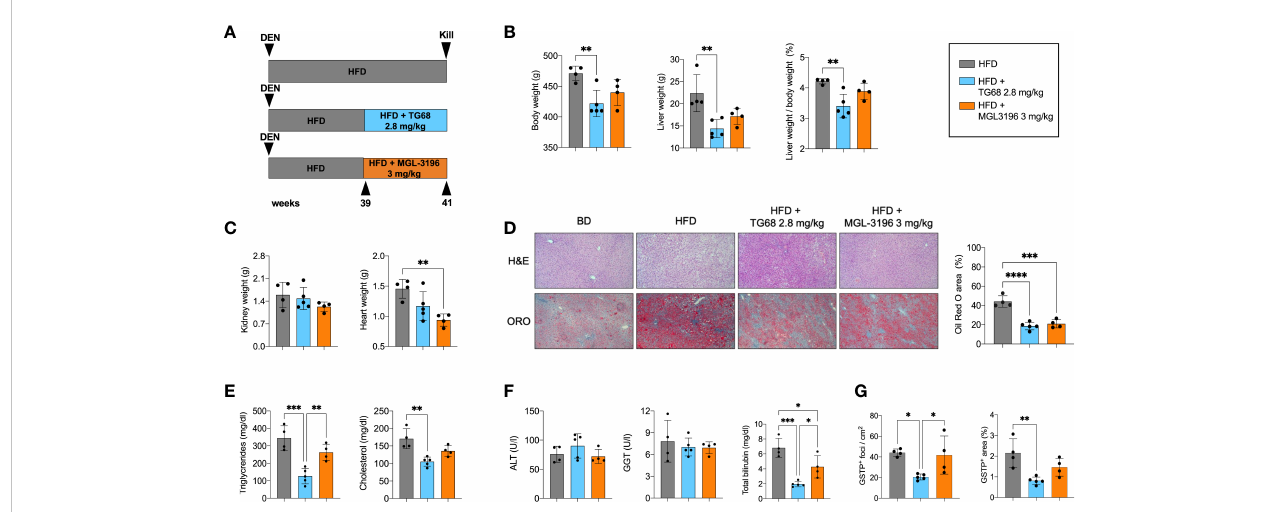
FIGURE 6 Resmetirom, unlike TG68, does not induce regression of preneoplastic foci. (A) Experimental design and timeline of the in vivo experiments; (B) Body weight, liver weight and liver weight/body weight ratio in rats fed HFD and then co-treated with 2.8 mg/kg of TG68 or 3.0 mg/kg of Resmetirom; (C) Heart and kidney weight of rats HFD alone or co-treated with 2.8 mg/kg of TG68 or 3.0 mg/kg of Resmetirom; (D) Representative images of liver sections stained with hematoxylin and eosin (H&E 10x) oor Oil Red O (ORO 10x) in rats treated as in A. Quanti fi cation of ORO staining positive area by using ImageJ; (E) Serum levels of triglycerides and cholesterol; (F) Serum levels of ALT, GGT and total bilirubin; (G) Number of GSTP + foci and percentage of liver occupied by GSTP + The bar graphs represent mean values + SD of 4 to 5 rats/group. Groups were compared by using one-way ANOVA followed by Tukey post hoc analysis. * p <0.05, ** p <0.01 , ***p <0.001 ,****p <0.0001. ALT, alanine aminotransferase; DEN, Diethylnitrosamine; HFD, high fat diet; MGL-3196, Resmetirom; GGT, gamma-glutamyl